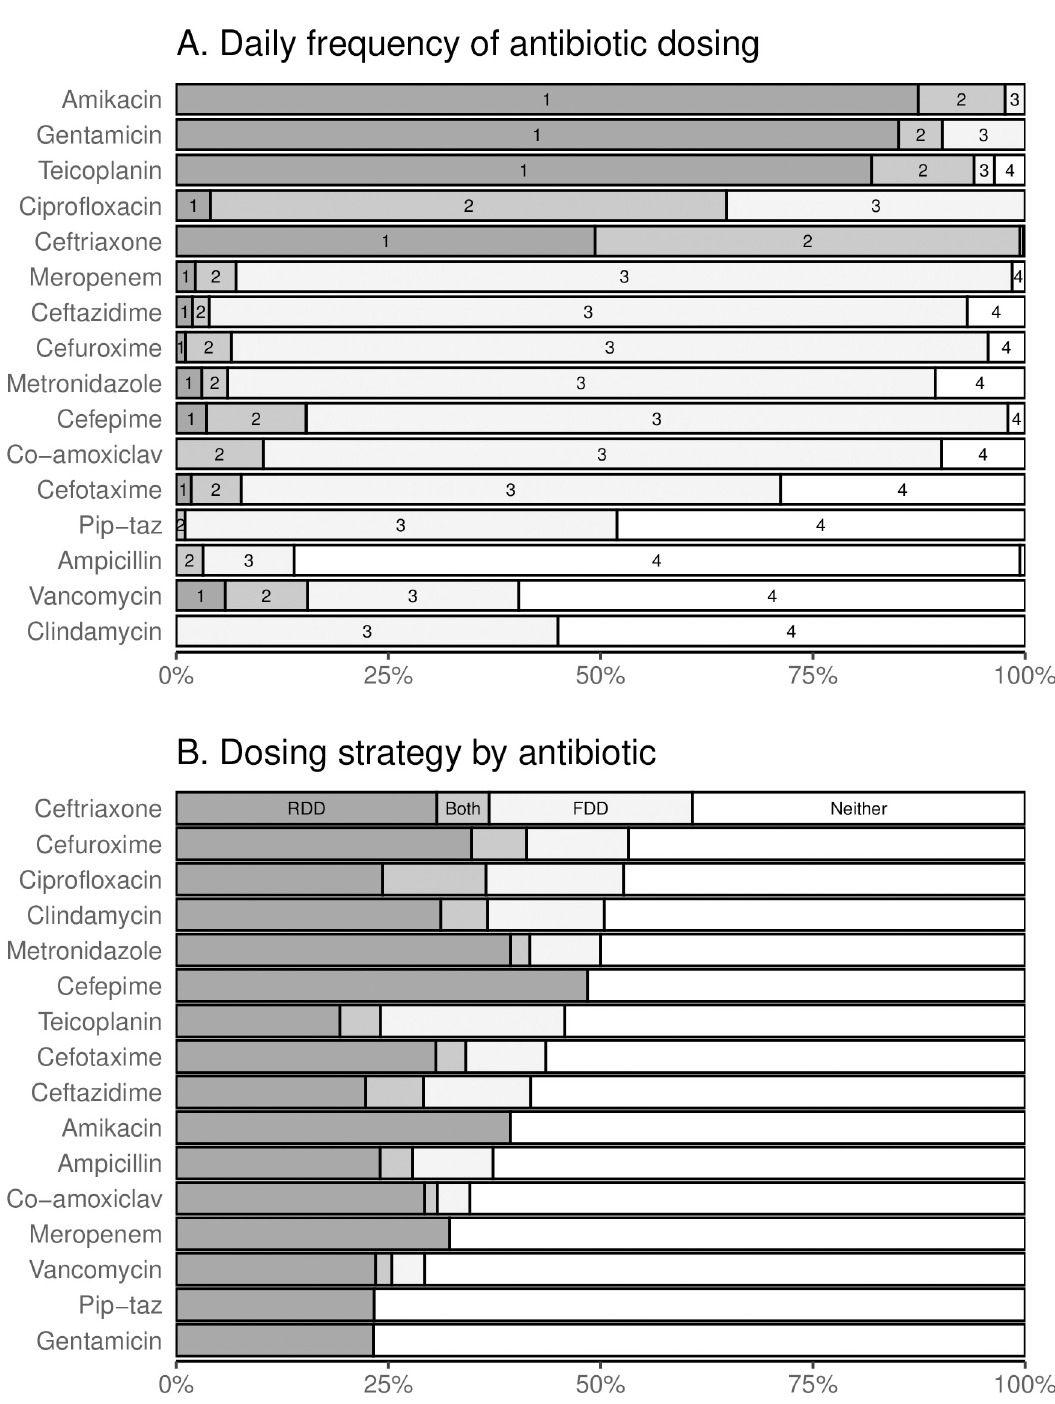
Fig 1. Frequency and dosing strategy by antibiotic. A. Frequency of antibiotic dosing within 24h. Antibiotics are ordered by most common frequency–once per day at the top and 4 times per day at the bottom. Note that frequency once per day includes 5 doses given less than once per day (e.g. every 36h). B. Dosing strategy for each antibiotic. Each dose was assigned to being consistent with dosing by fixed daily dose (FDD), weight-based dose (WBD), both or neither. Antibiotics are sorted by the proportion assigned to a dosing